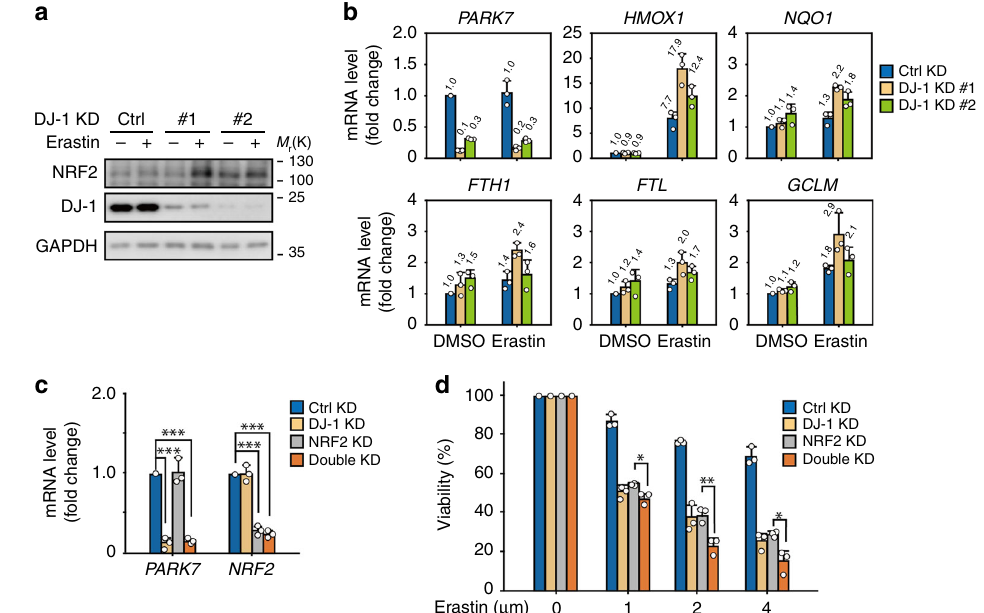
Fig. 3 NRF2 is not involved in DJ-1-regulated ferroptosis. a , b Indicated DJ-1 KD H1299 cells were treated with erastin (2 μ M) for 12 h. Independent experiments are repeated three times and representative data are shown. a The protein expression of NRF2, and b its known downstream genes were assayed. The relative gene expression is normalized to β -actin. c The mRNA expression of PARK7 and NRF2 in indicated H1299 cells was assayed by qRT- PCR (#1 sequence of DJ-1 KD was used here). The relative gene expression is normalized to β -actin and the error bar indicates the SD value from triplicates. d Viability of H1299 cells infected with shRNAs for 72 h (#1 sequence of DJ-1 KD was used here) and treated with erastin (1 – 4 μ M, 24 h). Data shown represent mean ± SD from three independent experiments. Comparisons were made using the two-tailed, unpaired Student ’ s t -test; * p < 0.05, ** p < 0.01, *** p <